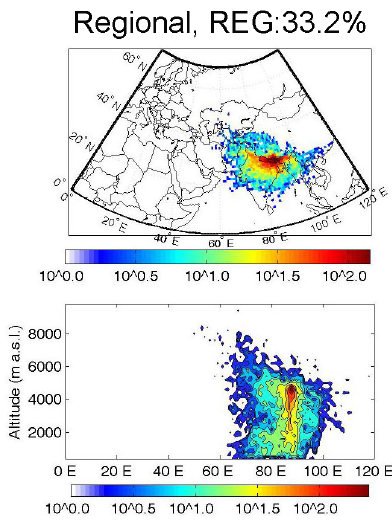
Fig. 5c. As in Fig. 5a but for regional “REG”